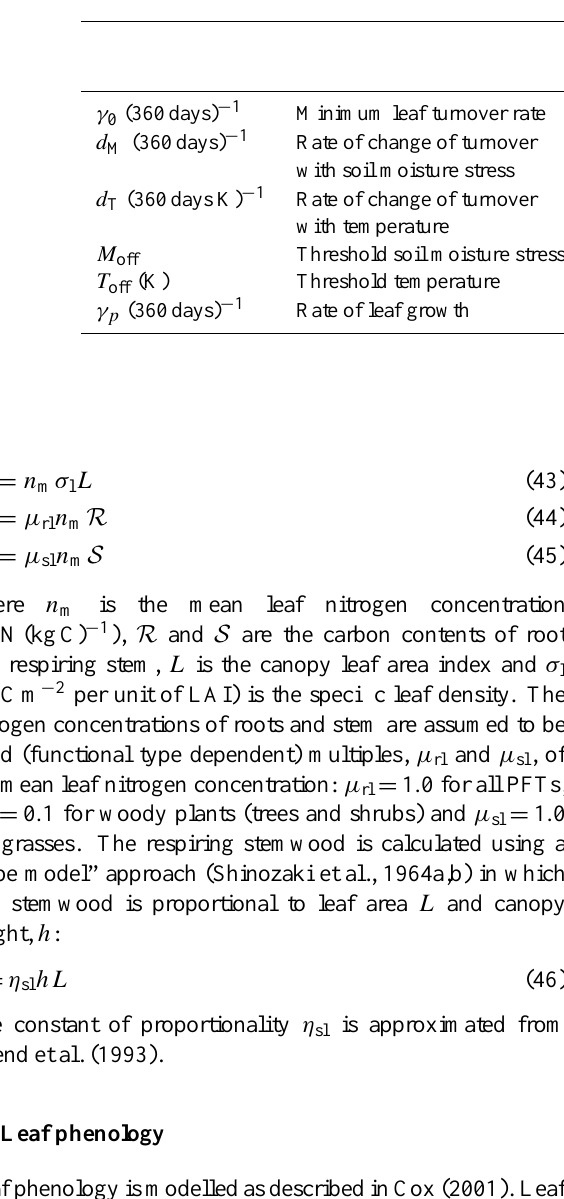
Table 5. Default values of PFT-specific parameters for phenology.